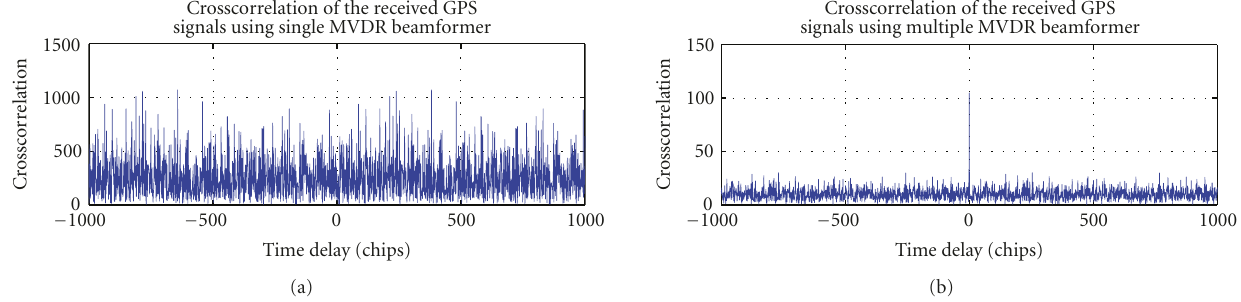
Figure 7: Cross-correlation of the received GPS for single and the first beamformer of the multiple MVDR beamformers with four RHCP